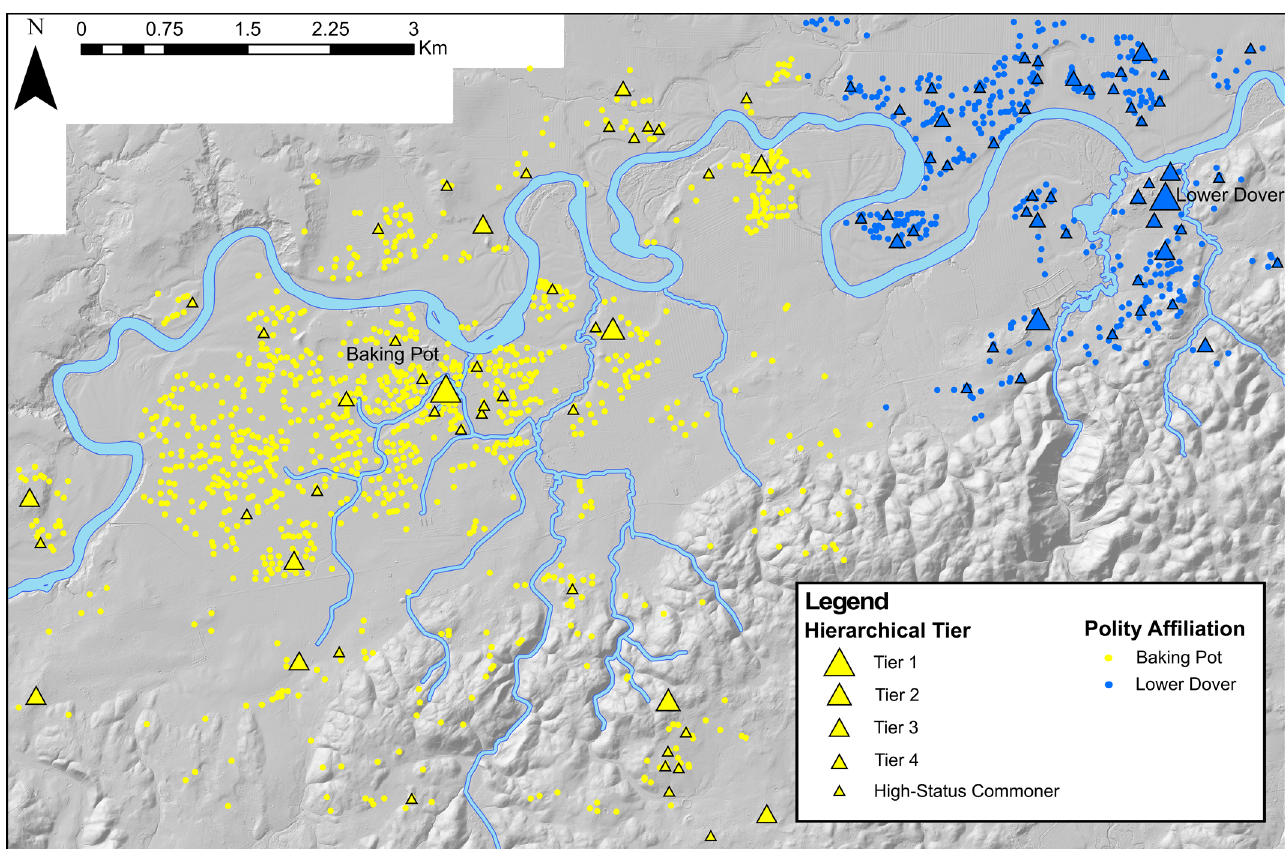
Figure 6. Xtent Model of Baking Pot and Lower Dover showing modeled labor catchments at the apical elite/polity scale.